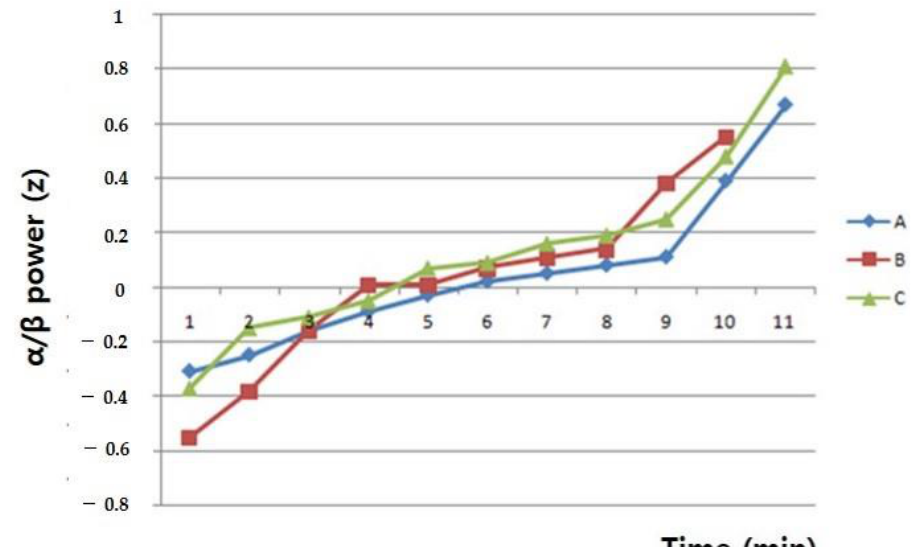
Figure 7. Asymmetry values with depressive disorder after WNS and placebo treatment. (A) 2.4 g of WNS group, (B) placebo group, (C) 4.8 g of WNS.